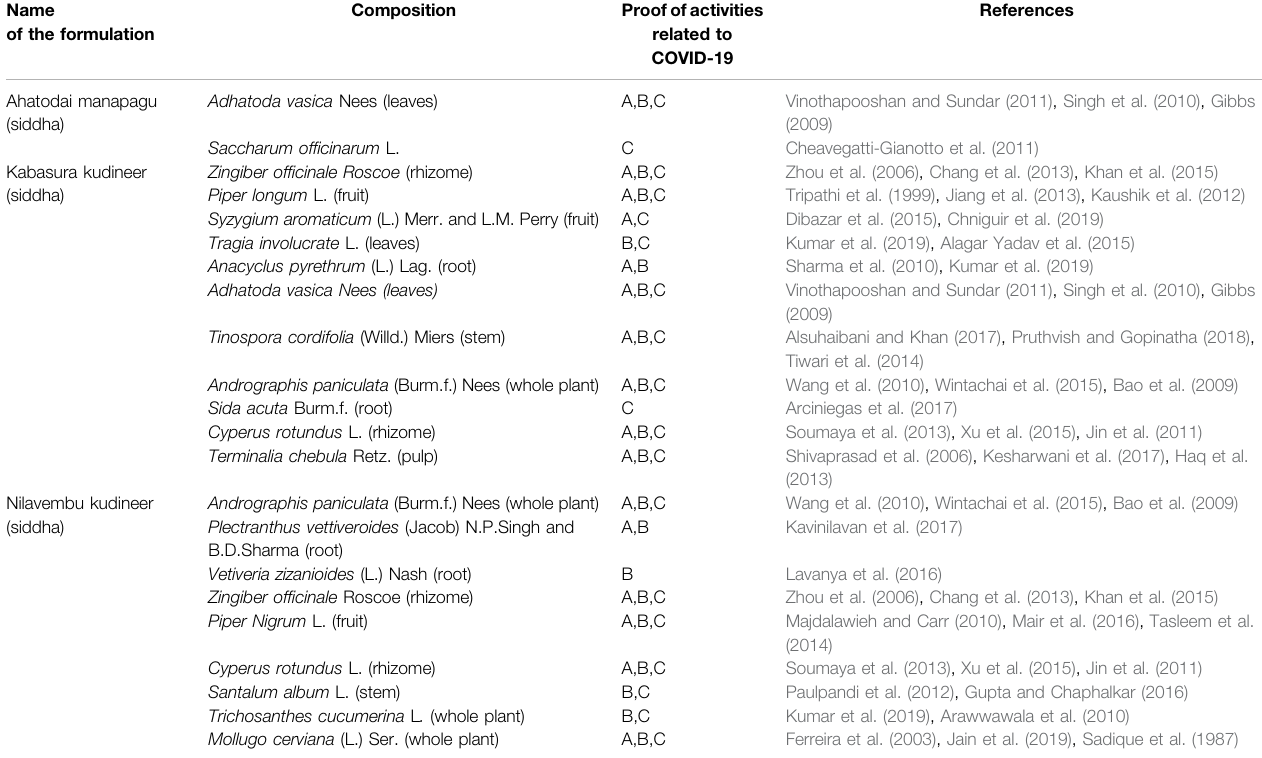
TABLE 4 | AYUSH recommended prophylactic approach through formulations of Siddha system of medicine. Ref: AYUSH Ministry of Health Corona Advisory – D.O. No. S. 16030/18/2019-NAM; dated: 06th March, 2020. Name of the